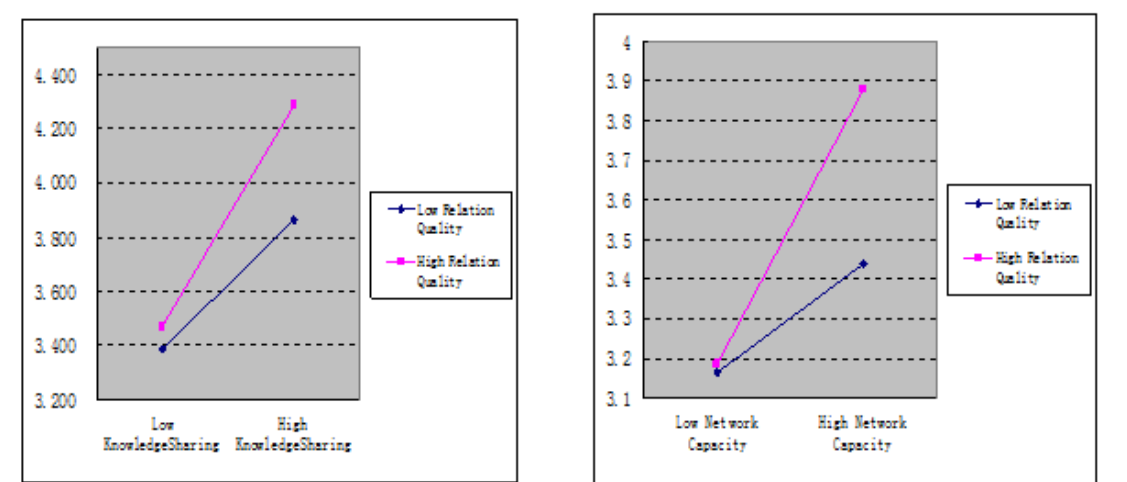
Figure 2. Moderating effect of RQ on the relation of KS and SIP Figure 3. Moderating effect of RQ on the relation of NC and